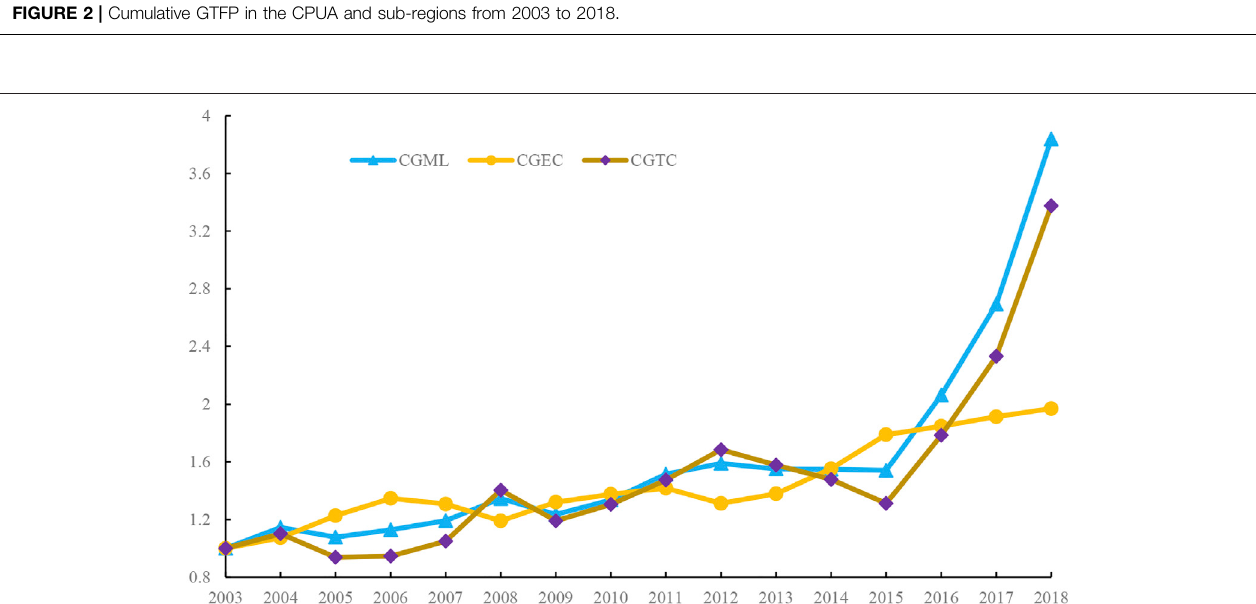
FIGURE3| ThreecumulativeGTFPindicesintheCPUAfrom2003to2018.Note:ThegeometricmeanoftheGTFPofthe29citiesintheCPUAisusedastheindex of each year.